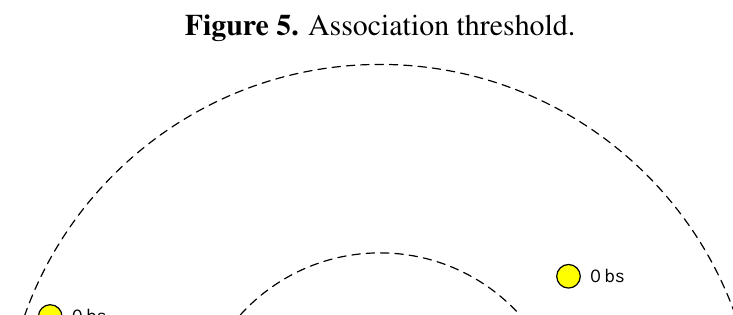
Figure 5. Association